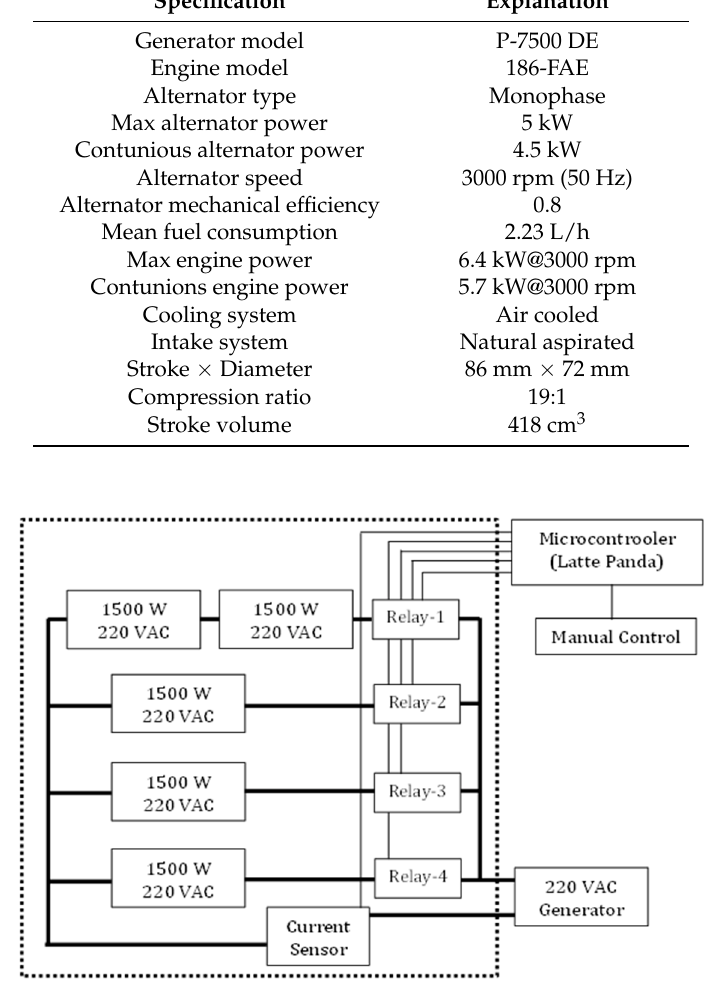
Figure 1. Resistive load cycle.